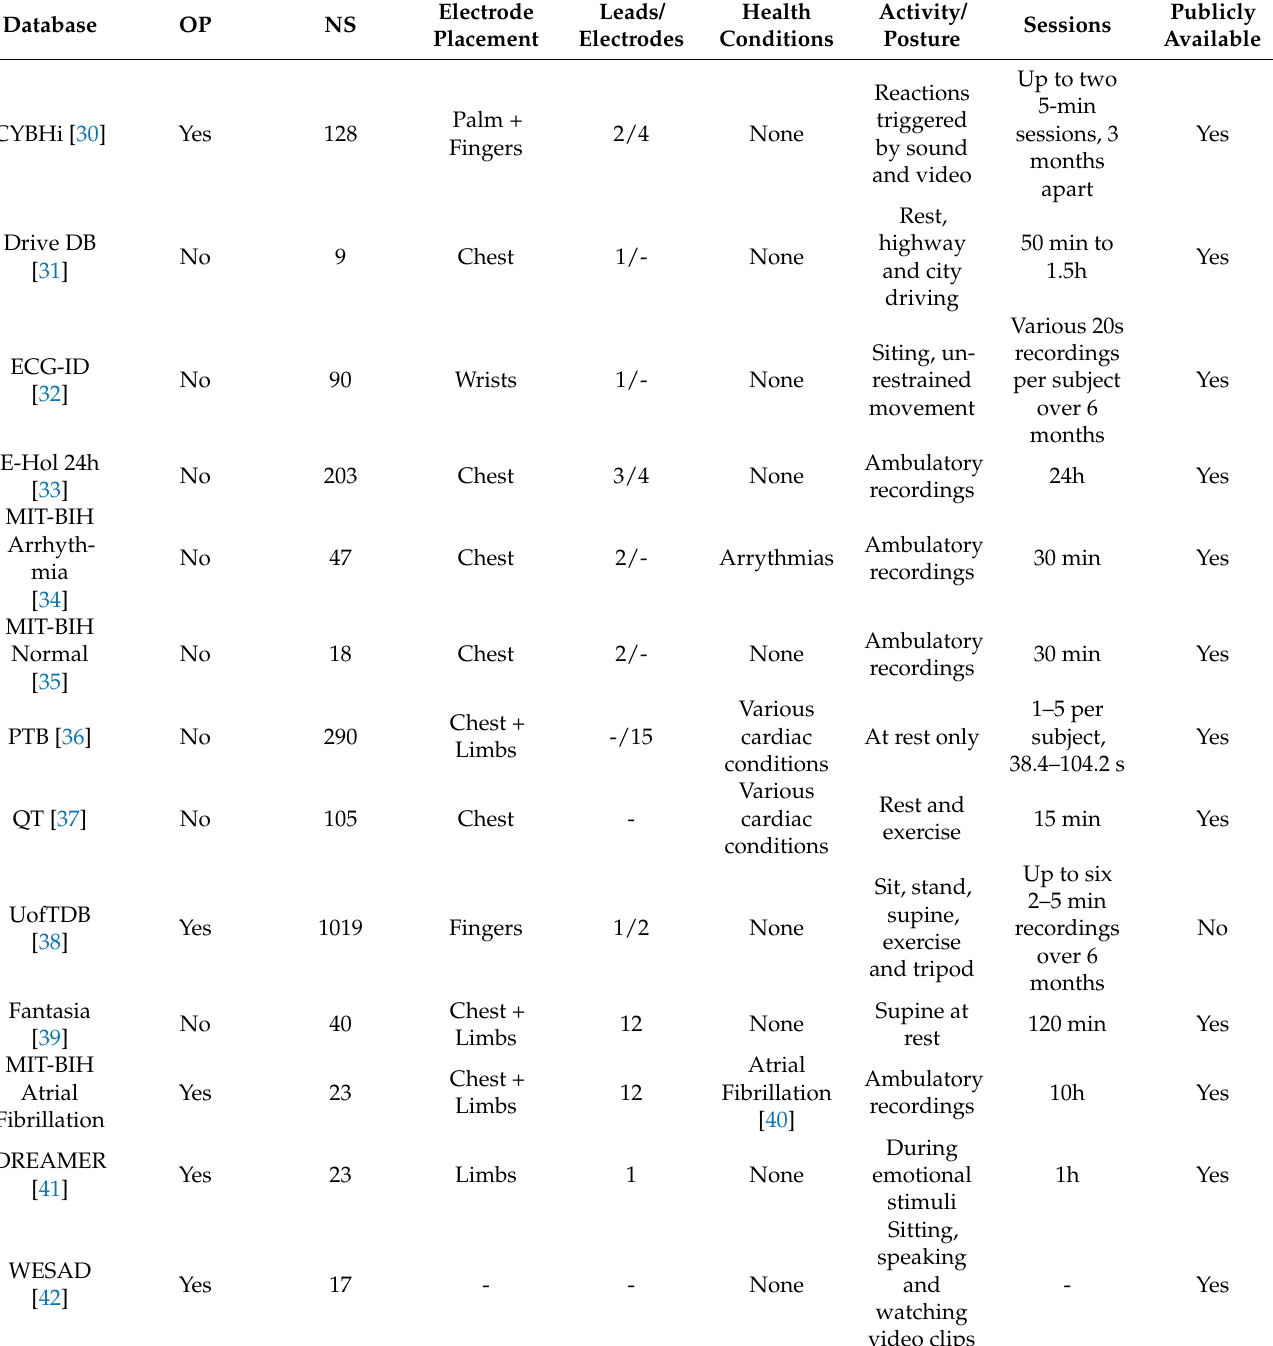
Table 2. Overview of the most used databases in the